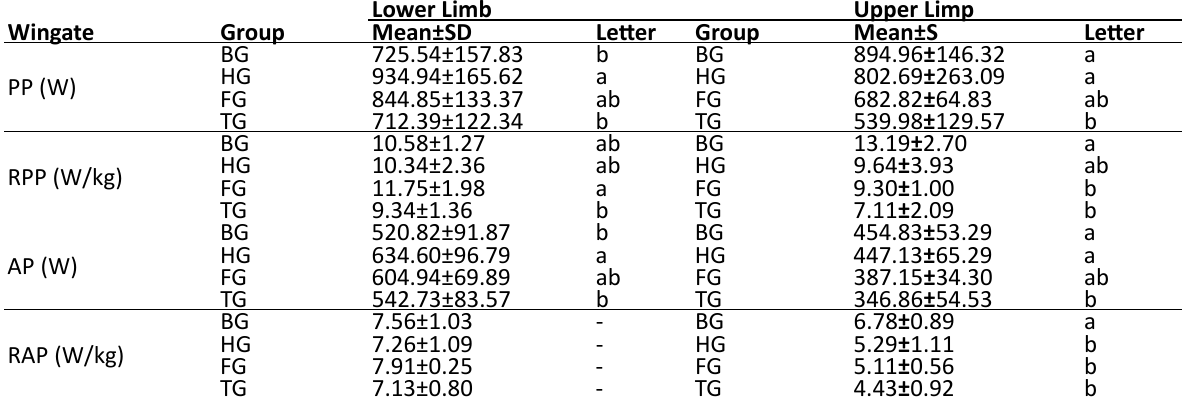
Table 2. Wingate results of participants’ upper and lower extremities categorized in